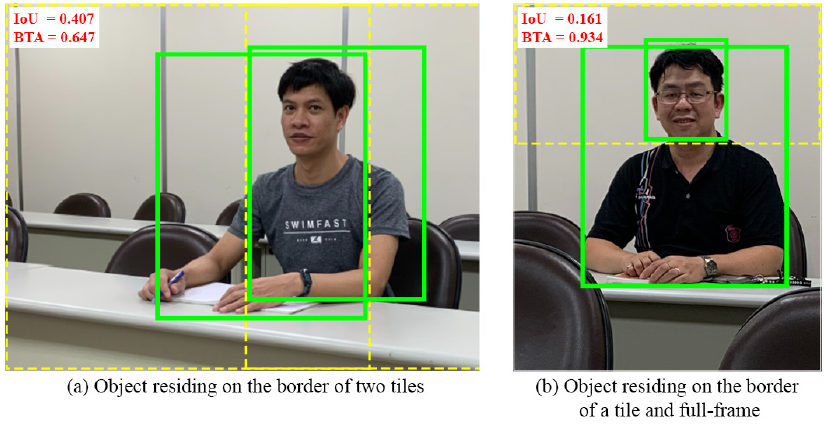
Figure 6. Illustration of an object residing on the